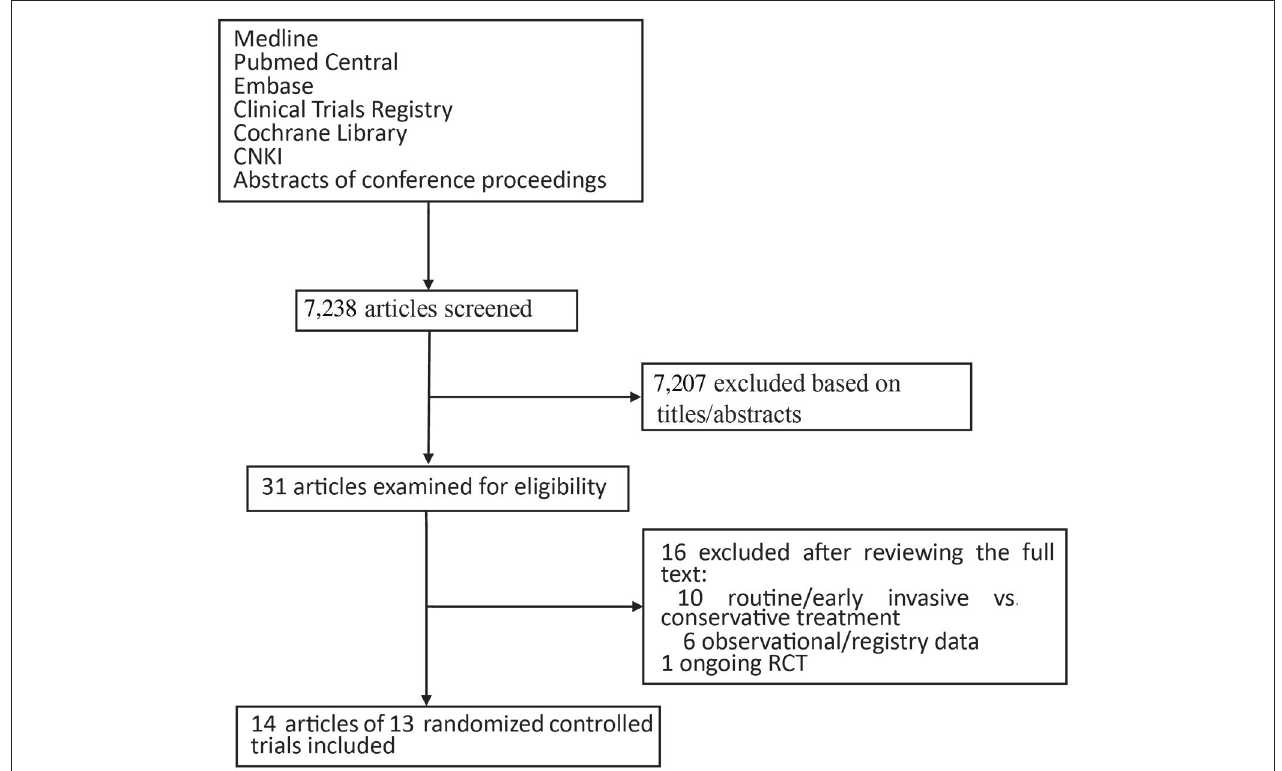
FIGURE 1 | Flow chart of the study selection